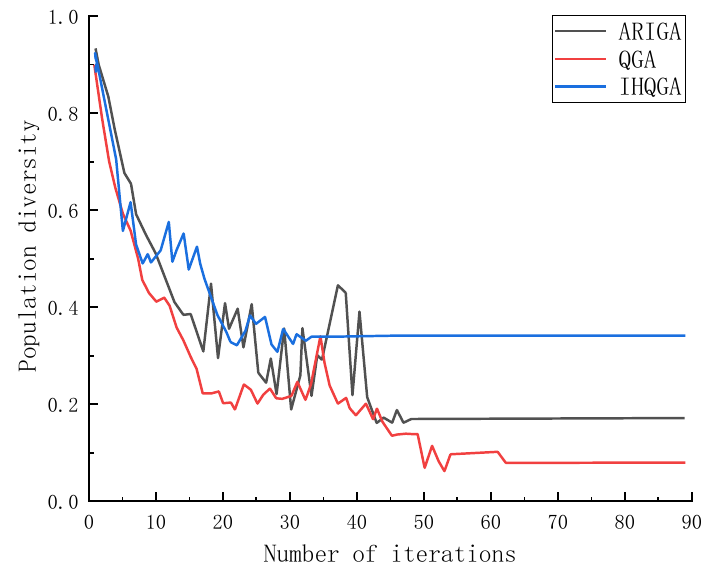
Figure 5. Population diversity change process.